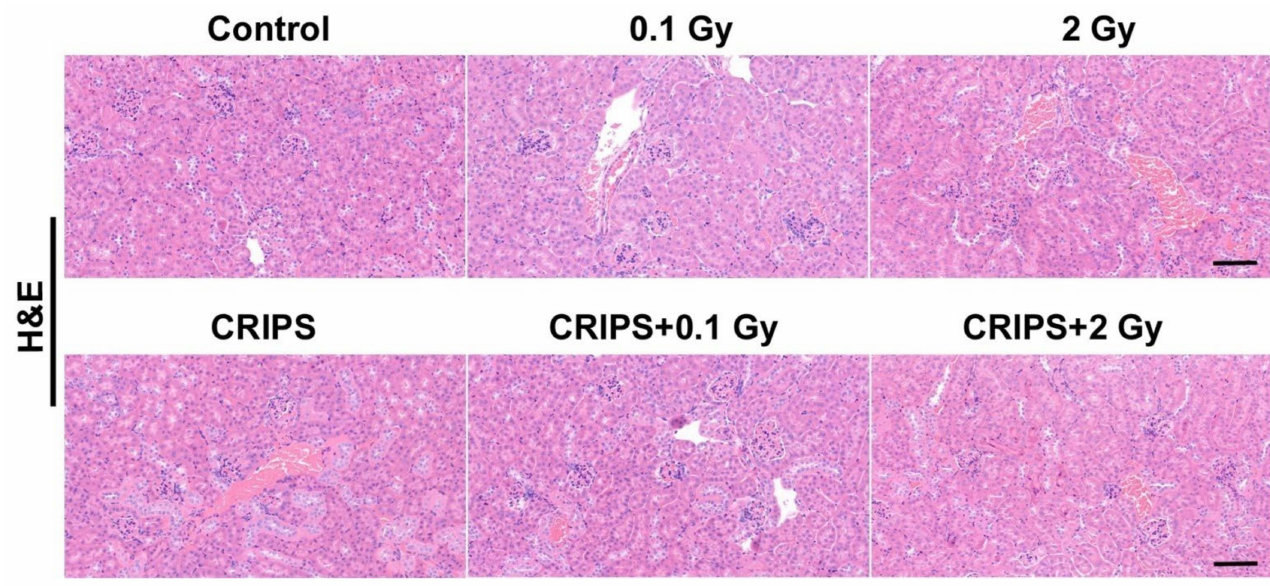
Figure 1. H&E staining of renal sections from Trp53 +/ − mice (magnification, 200 × ; scale bar = 100 µ M). CRIPS, chronic restraint-induced stress.